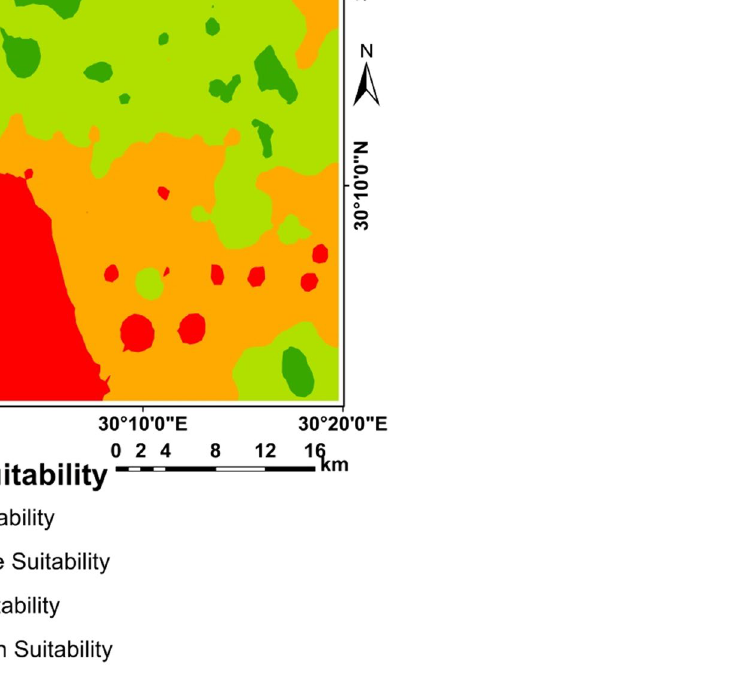
Figure 9. Potential suitability based of